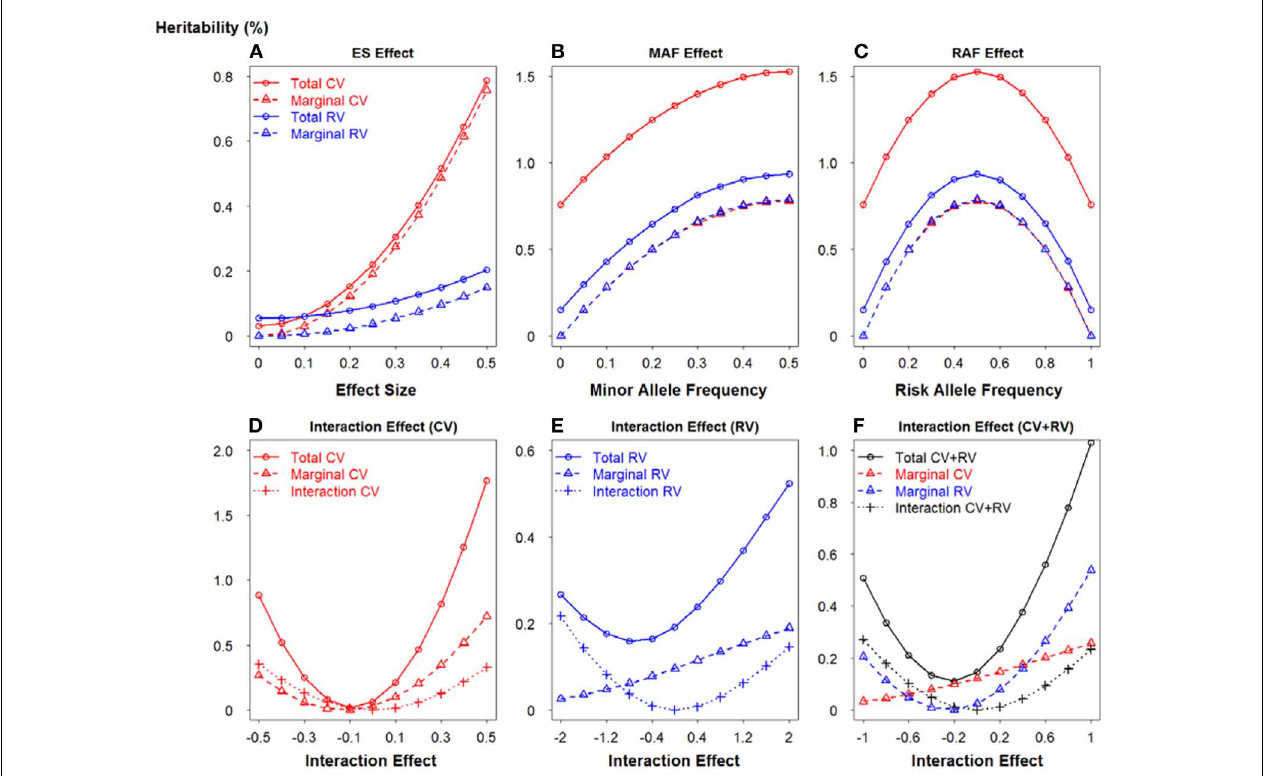
FIGURE 5 | Relationship between effect size, minor allele frequency, risk allele frequency, interaction effect and heritability. (A) Relationship between heritability and effect size. (B) Relationship between heritability and minor allele frequency. (C) Relationship between heritability and risk allele